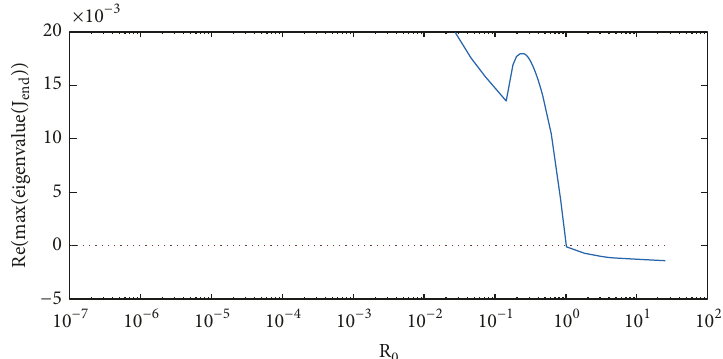
Figure 3: Zoom of the maximum real part of the eigenvalues versus the reproduction number close to the stability region boundary.